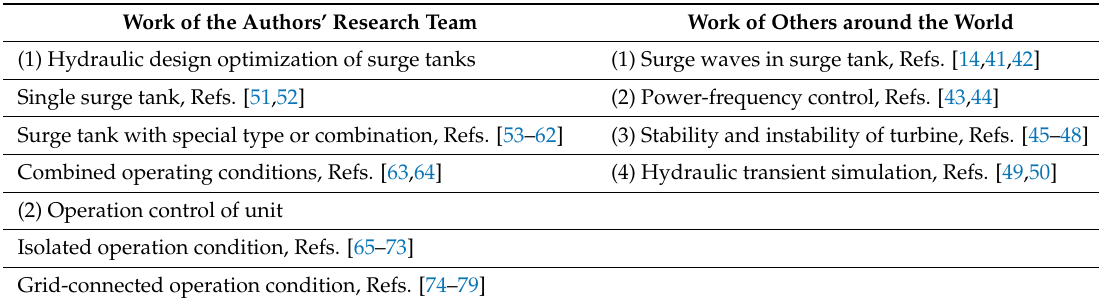
Table 1. Comparison of the relevant work between the authors’ research team and others around the